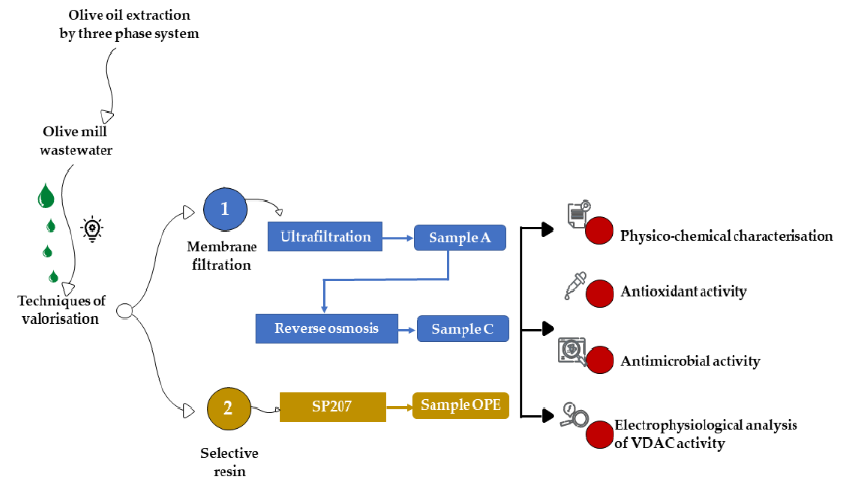
Figure 1. Experimental design.